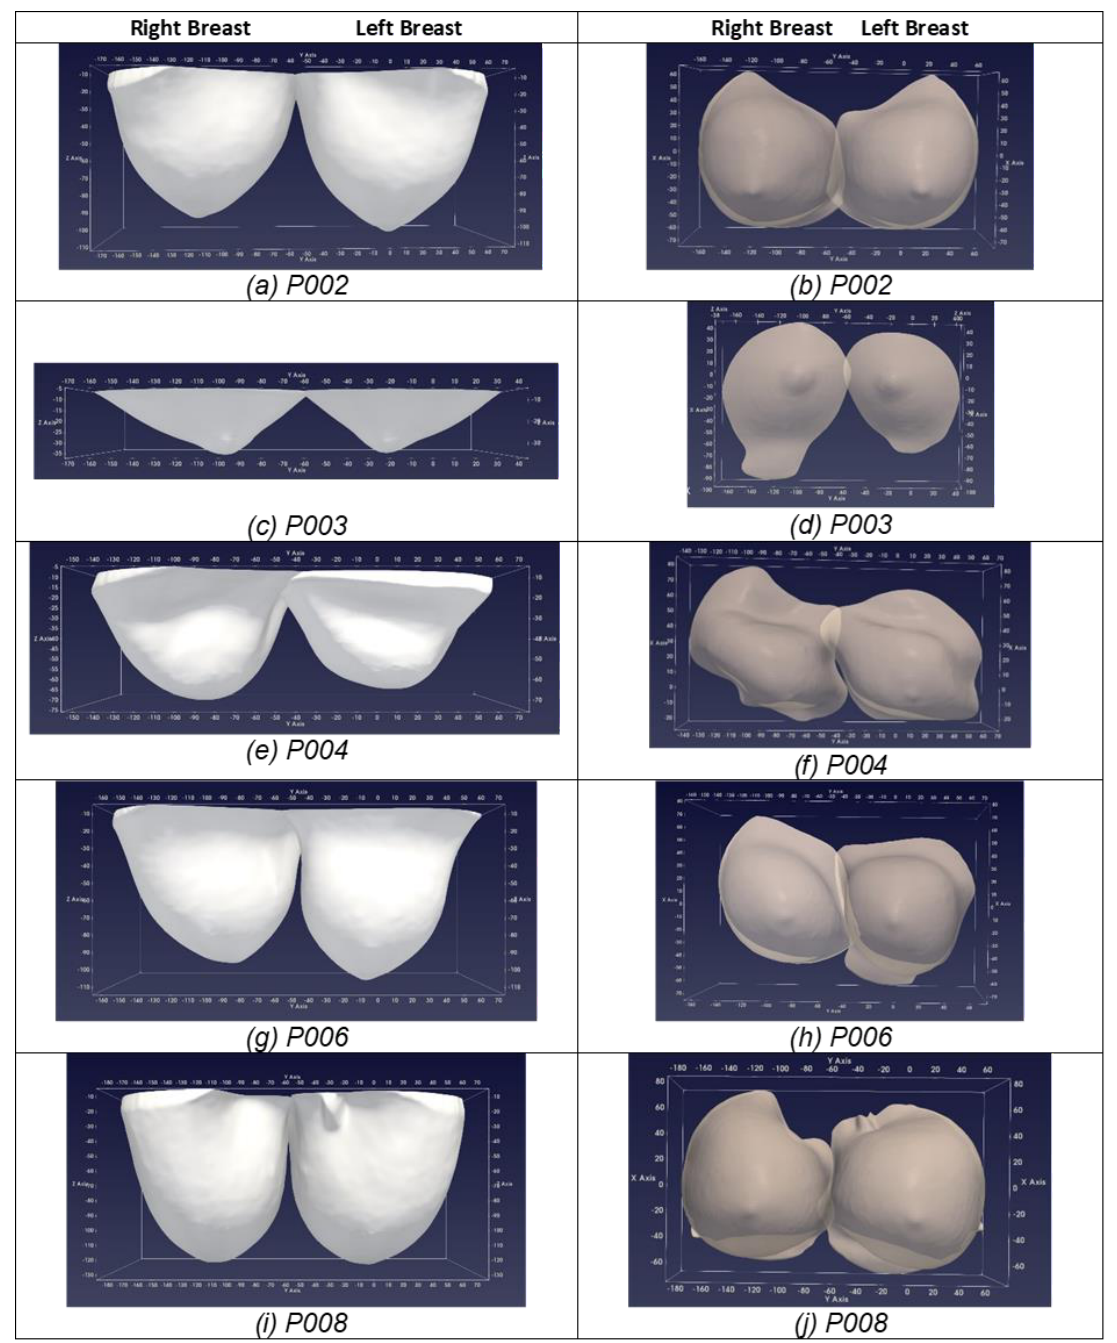
Figure 33. Breast Anatomy, as seen in the Wavelia OBCD scanner: Side view ( Left ), Supine position mimicking view ( Right ) - the first five patient scans.